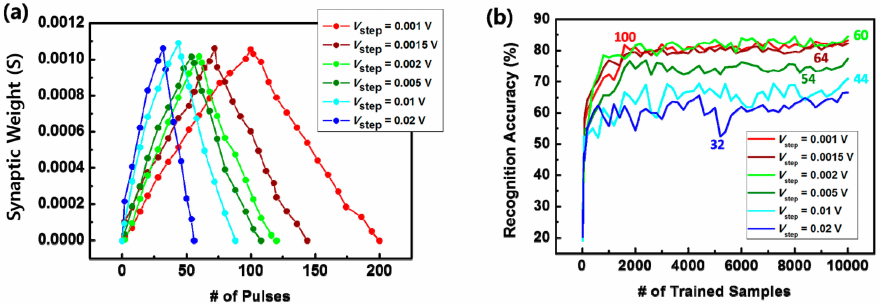
Figure 8. MNIST pattern recognition result by using the ISPP scheme. ( a ) The gradual conductance change by applying various V step ; ( b ) Recognition accuracy as a function of the training samples for the various V step . The number means the weight levels (maximum pulse number).